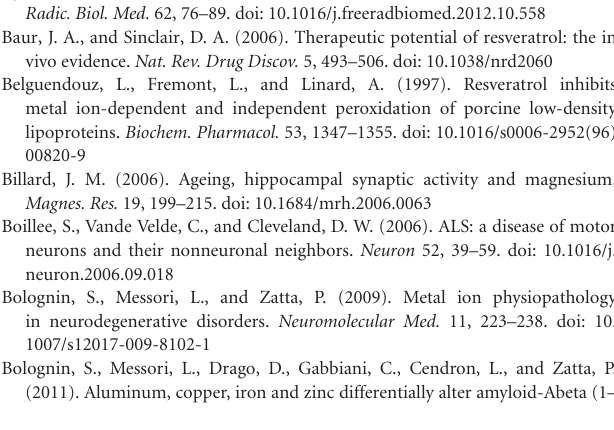
FIGURE 2 | Metal ions dyshomeostasis is closely related to different hallmarks of AD pathogenesis, mainly protein misfolding, ROS production, mitochondrial failure and inflammation . In this figure the